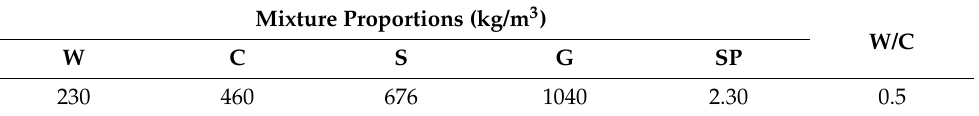
Figure 8. Test Figure 8. Test process. Figure 8. Test process.